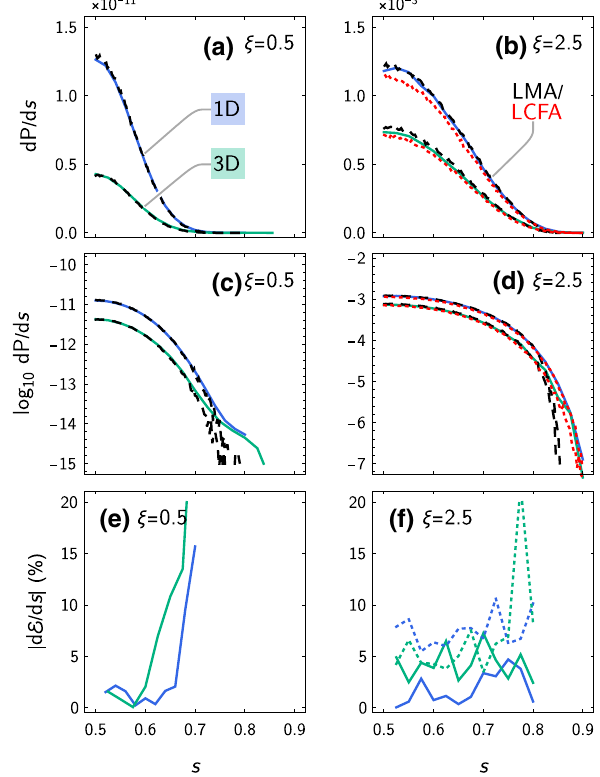
Fig. 10 Lightfront momentum spectra d P / d s for a photon withenergy parameter η = 0 . 2collidingwithaplane-wave(blue)orfocused(green) laser pulse of peak amplitude ξ = 0 . 5 (left column) and 2 . 5 (right column) and duration N = 16. In the focused case, the waist w 0 = 5 λ and the photon beam has radius 2 λ . a – d Results from QED (solid), LMA-based simulations (black, dashed) and LCFA-based simulations (red, short-dashed). e , f Percentage error made by the LMA (solid) and LCFA (dashed) simulations, in the plane-wave (blue) and focused (green)